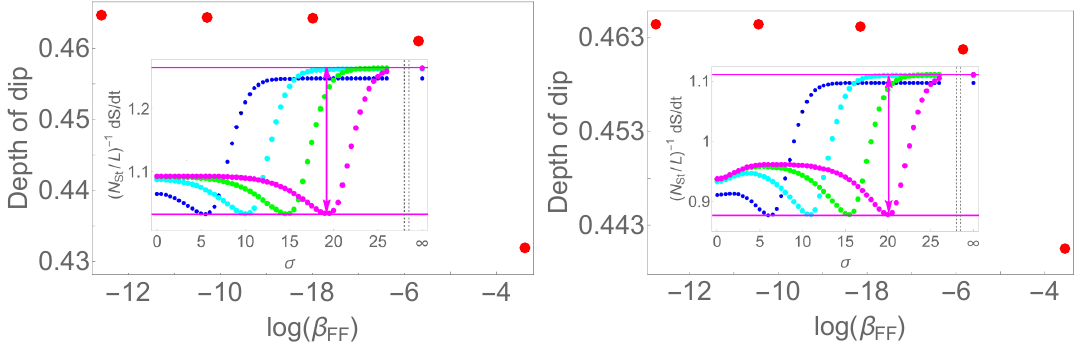
Figure 8 . The depletion of the normalised entropy production rate L is visualised as a function of β green and magenta in the insets correspond to ´ log β